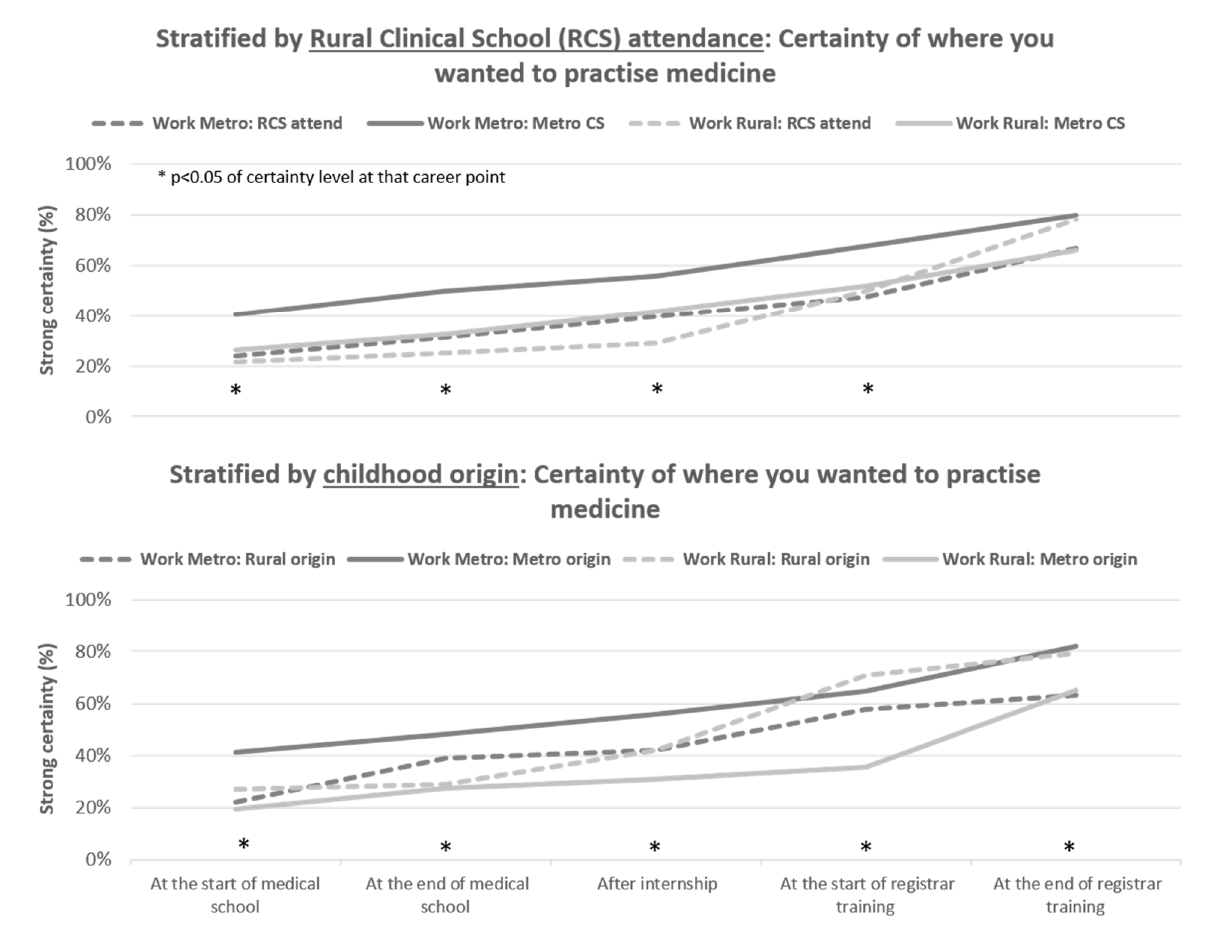
Figure 4. Level of certainty of their practice location decision amongst junior doctors, by key rural strata (childhood origin, clinical school training location).